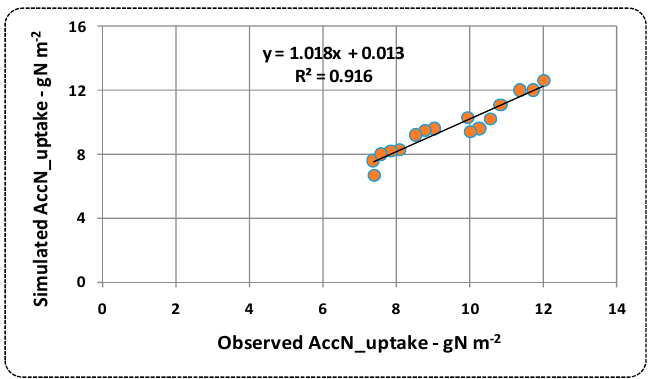
Figure 13. Observed versus simulated accumulated-nitrogen uptake for all treatments for two seasons.